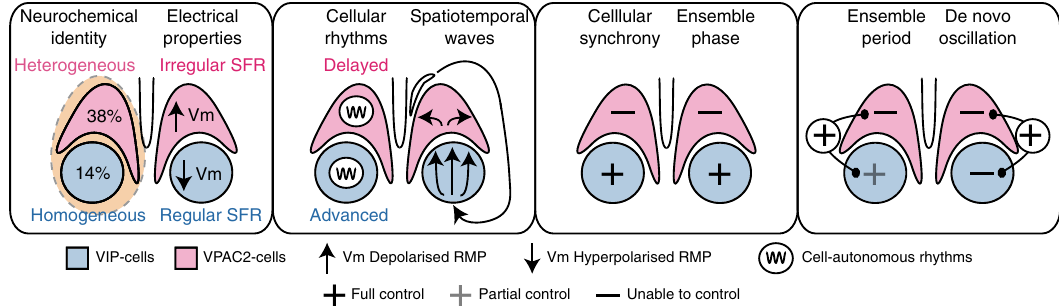
Fig. 9 The VIP-VPAC2 neuropeptidergic axis as a pacemaking hub within the suprachiasmatic nucleus circadian circuit. Summary diagram showing the cellular properties of the VIP-VPAC2 neuropeptidergic axis and their control of SCN emergent properties. VIP and VPAC2 neurons are neurochemically, electrophysiologically and spatially distinct SCN subpopulations. VIP neurons are phase advanced relative to VPAC2 neurons with a tight spatiotemporal organisation exhibiting dorsal to ventral waves, while the VPAC2 neurons are phase delayed with a looser medial and lateral spatiotemporal distribution. VIP cells can control cellular synchrony, ensemble phase and weakly contribute to ensemble period while VPAC2 cells cannot de fi nitively control any of these emergent properties. However, both populations together are required to exert full pacemaking control and initiation of de novo